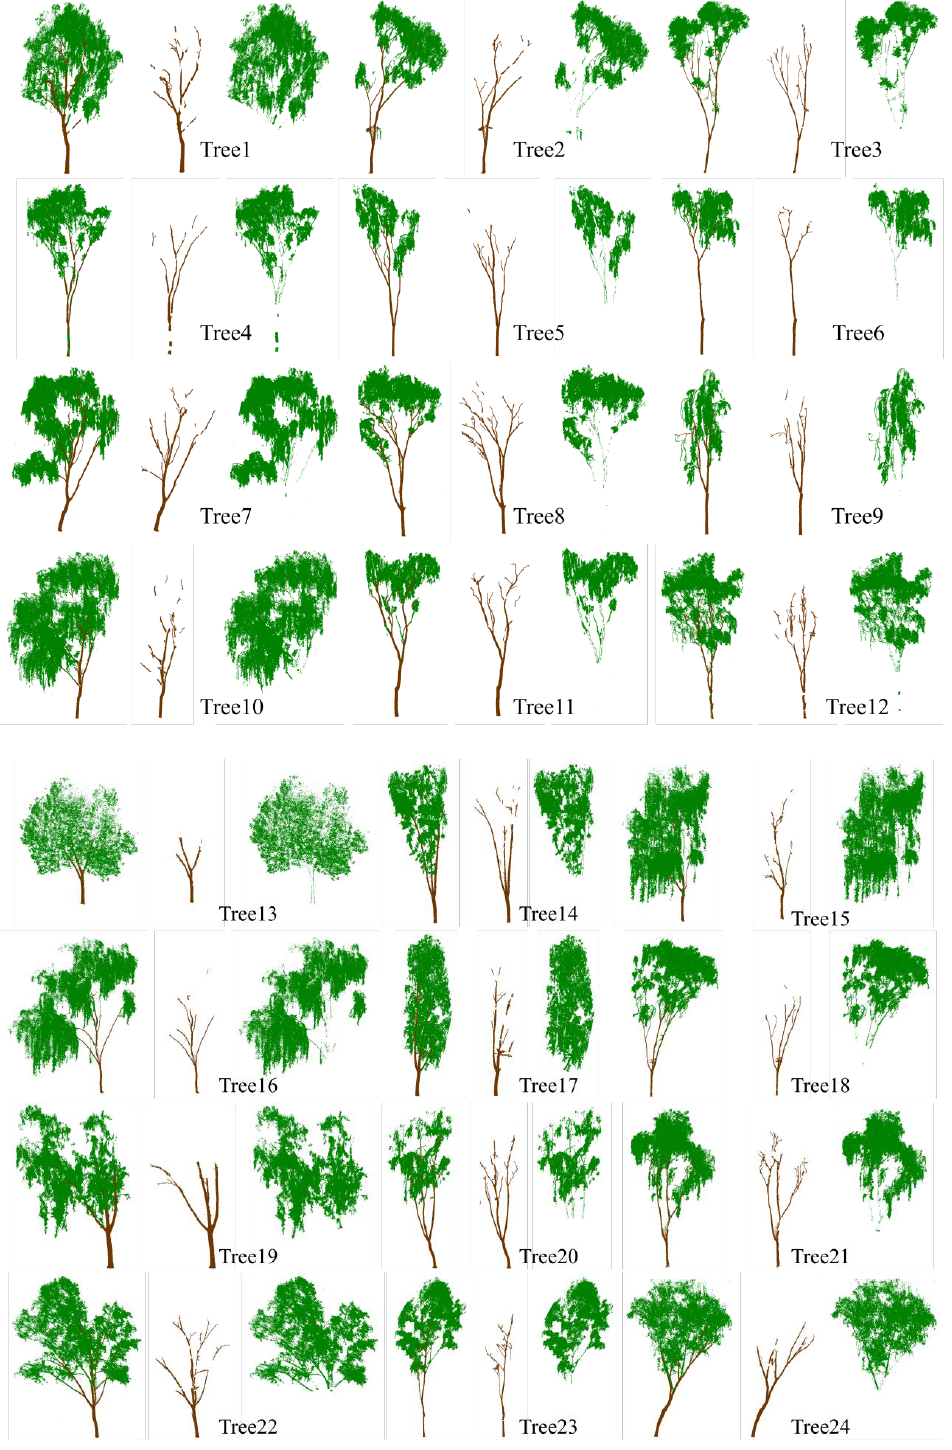
Figure 11. The demonstration of 24 tree classification results. The wood–leaf classification result of each tree contains three sub-graphs (left: all tree points; middle: classified wood points; right: classified leaf points). Brown: wood points; green: leaf points.